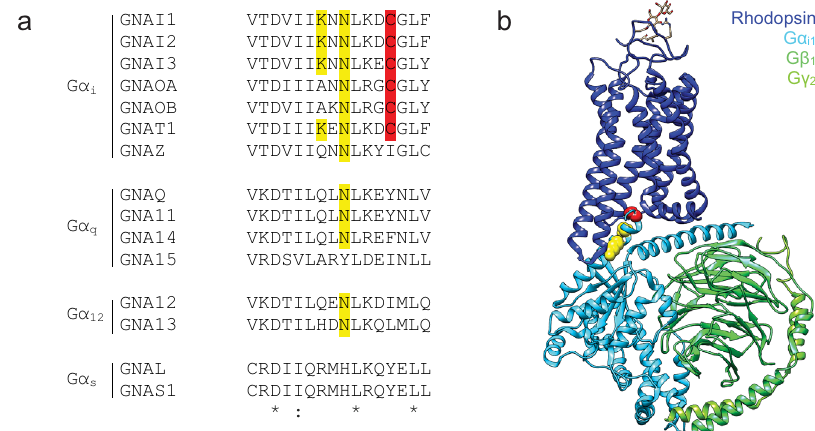
Fig. 1 Identi fi cation of G α carboxy-tail amino acid residues that are putatively ADP-ribosylated by OZITX. a Amino acid sequence alignment of carboxy- termini residues of heterotrimeric G α proteins. Sequences were aligned with Clustal Omega version 1.2.4. ‘ * ’ represents a completely conserved residue. ‘ : ’ represents a conserved residue (>0.5 in the Gonnet PAM 250 matrix). ‘ . ’ represents a weakly conserved residue ( ≤ 0.5 and >0 in the Gonnet PAM 250 matrix). Cysteine residues ADP ribosylated by PTX are indicated in red. Putative lysine and asparagine residues ADP ribosylated by OZITX identi fi ed by Littler and colleagues 23 are indicated in yellow. The asparagine residue that is a putative substrate is conserved across many G α subunits. b The location of OZTX ’ s and PTX ’ s substrate amino acid sites within a GPCR – G protein complex. The structure of rhodopsin bound to G α i1 β 1 γ 2 is depicted in the cartoon (PDB code 6CMO). Rhodopsin is shown in dark blue, G α i1 in light blue, G β 1 in green and G γ 2 in light green. The carboxy-terminal Cys 351 residue ADP ribosylated by PTX is shown in red spheres. Lys 345 and Asn 347 , the putative residues ADP ribosylated by OZITX, are highlighted in yellow spheres. Graphic constructed using UCSF